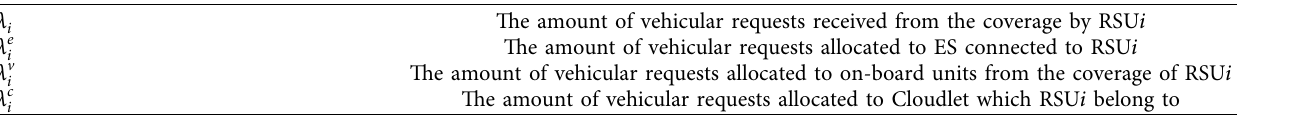
Table 1: Distribution table of the vehicular requests.